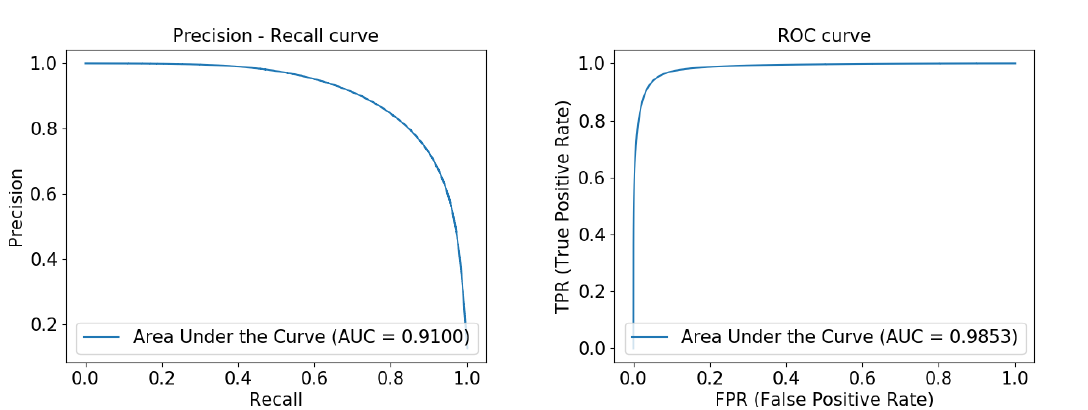
Figure 7. Precision-recall curve and ROC curve experimentally obtained from FAU-Net on the DRIVE data set from left to right.